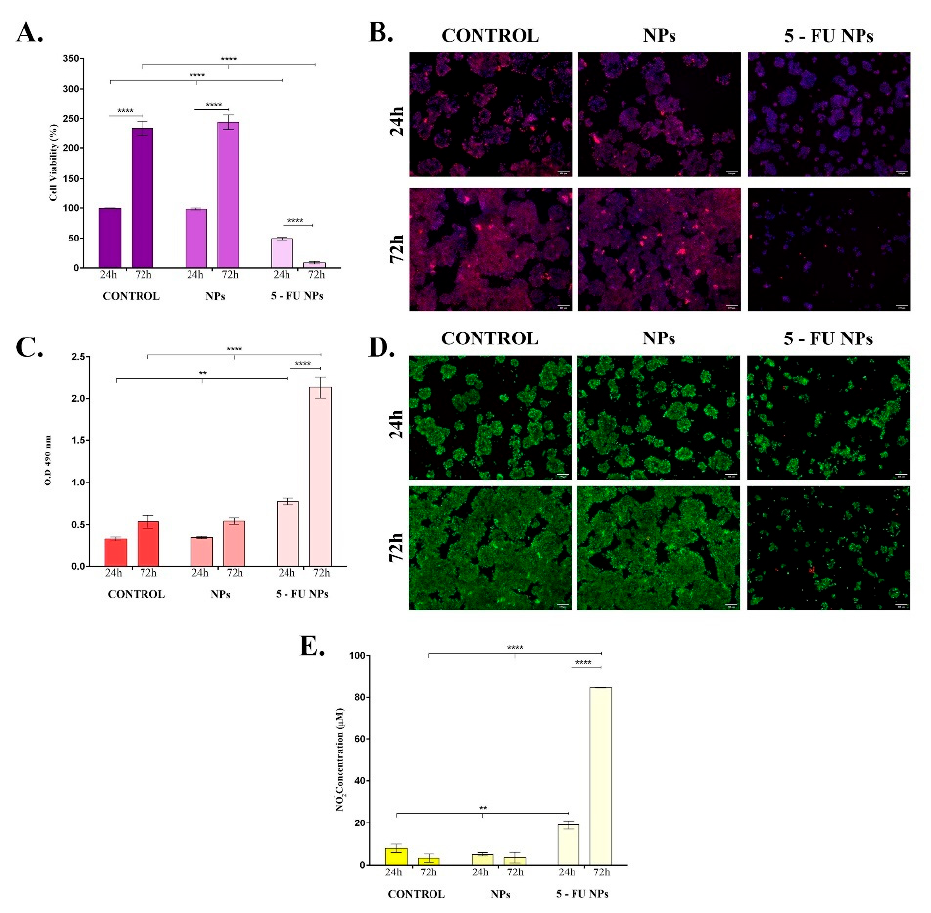
Figure 5. In vitro basic cytotoxicity screening of simple and 5-FU PEGylated SF NPs. The cytotoxicity of the pristine and 5-FU loaded SF/PEG NPs (12 mg/mL) was investigated after 24 h and 72 h